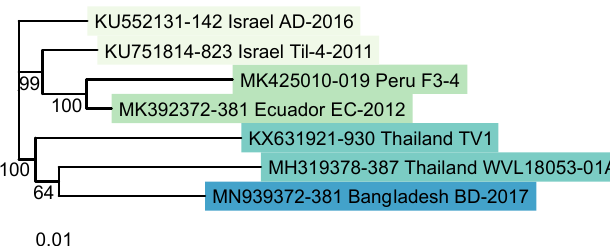
Figure 2. Maximum likelihood phylogenetic tree of TiLV genomes (concatenated coding regions from segments 1–10), based on 8871 nucleotide positions, using the Tamura Nei model of nucleotide substitution with gamma-distributed rate heterogeneity (TN93 + G). Bootstrap values were calculated from 1000 replicates, and percent support is shown on nodes where values exceed 50%. Scale bar shows number of substitutions per site.